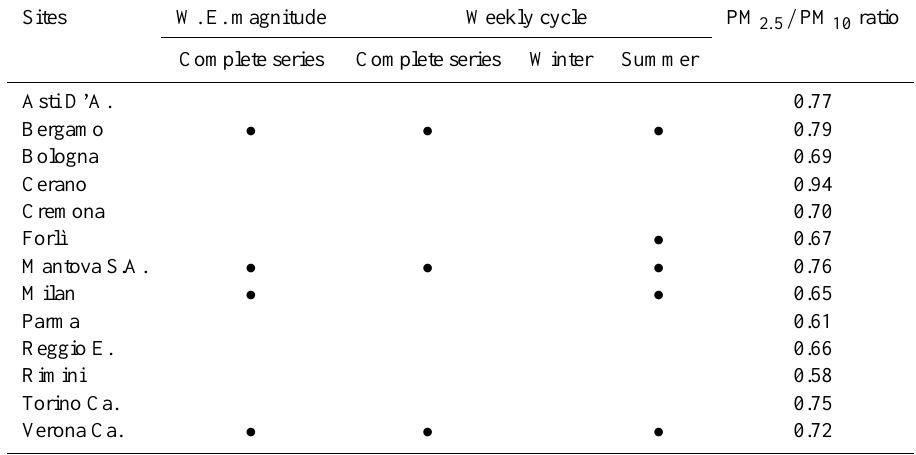
Table 5. Results of weekly cycle analysis on PM 2 . 5 at monitoring sites where both PM 10 and PM 2 . 5 are sampled: black dots